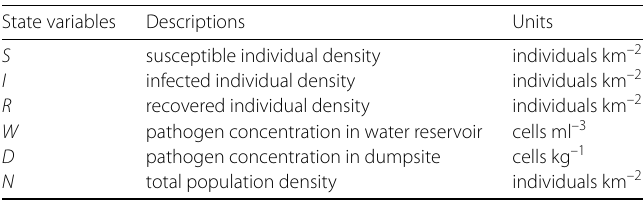
Table 1 Description of state variables and units for SIWDR model (2.1)